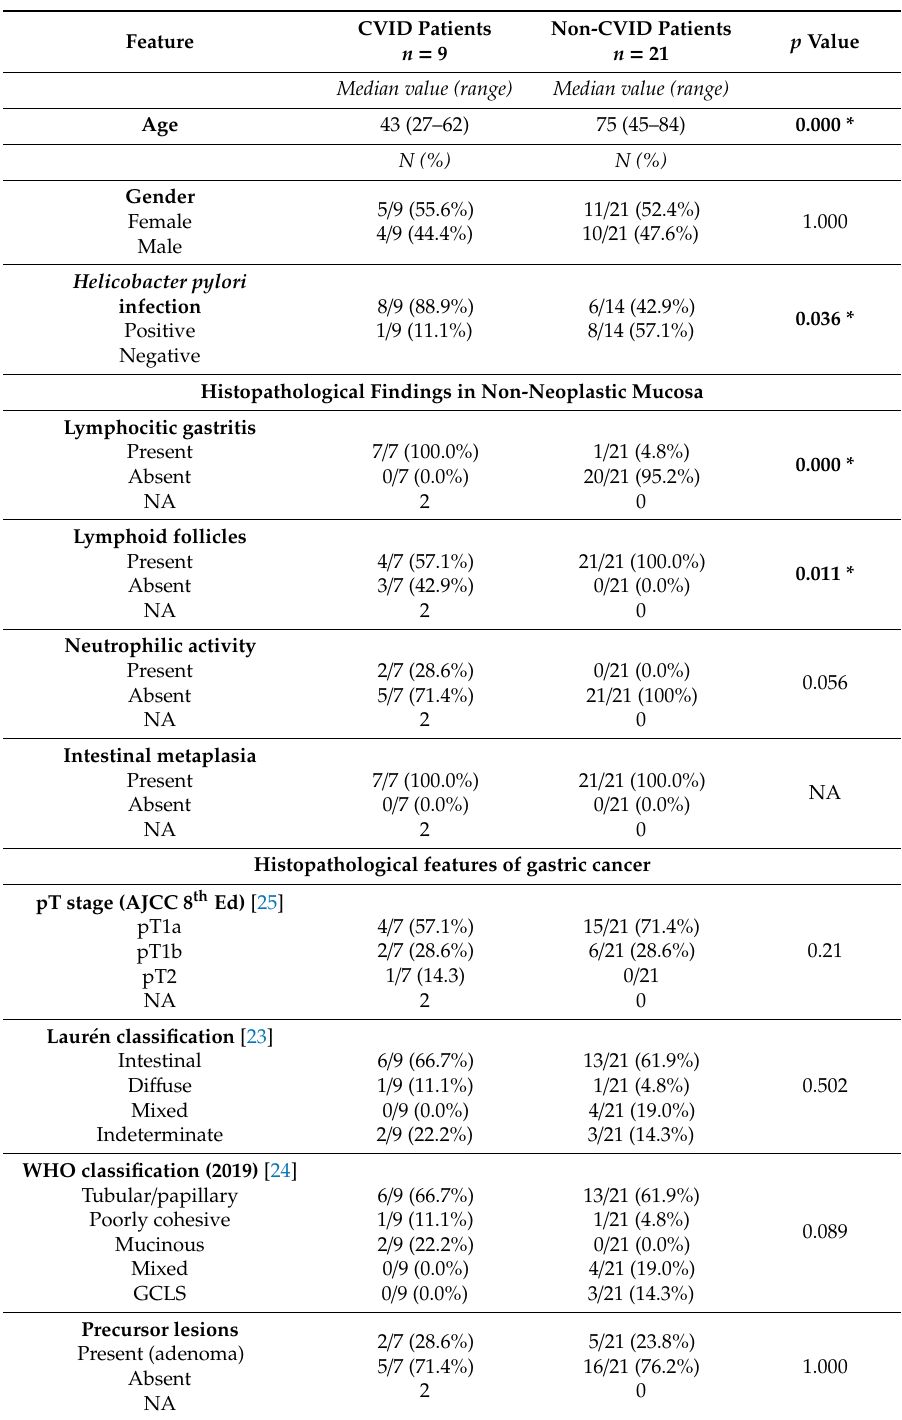
Table 1. Clinicopathological characteristics of CVID patients with gastric cancer in comparison with a control group of non-CVID patients with early stage gastric